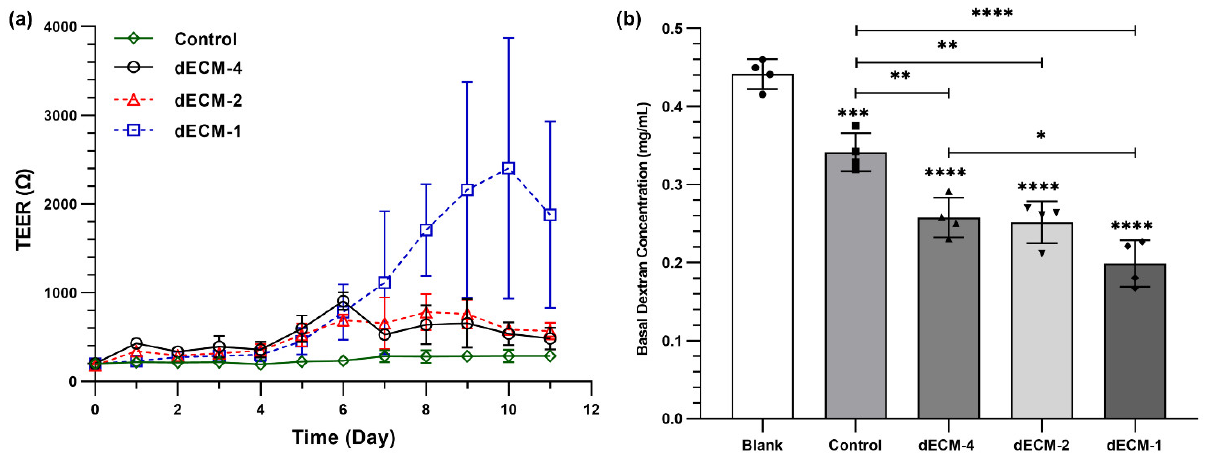
Figure 8. Barrier function of human primary epithelial cells grown at ALI. ( a ) TEER measurement for coated and non-coated Transwell membrane. ( b ) Permeability testing of the cells using fluorescent dextran (4 kDa). * p ≤ 0.05, ** p ≤ 0.01, *** p ≤ 0.001, and **** p ≤ 0.0001. Control represents cells seeded on Transwell inserts without coating.